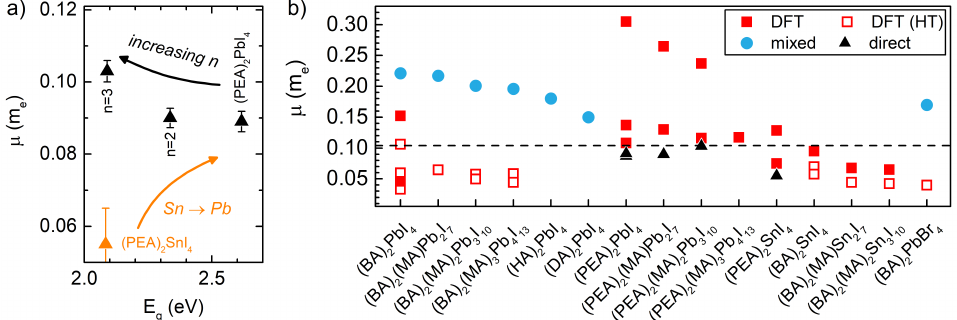
Figure 3. ( a ) Reduced effective masses obtained from interband magneto-absorption studies for differ- ent 2D layered perovskites. Arrows are guides to the eye. ( b ) Juxtaposition of the directly measured reduced effective mass with values obtained by various other methods (DFT-HT—DFT computed mass for the high-temperature motif). Dashed line indicates µ of (MA)PbI 3 [10]. The DFT values from Ref. [14,49–53], DFT-HT values from Ref. [14,48,52–55], mixed data from Ref. [31,33,38,56], direct data from Ref.